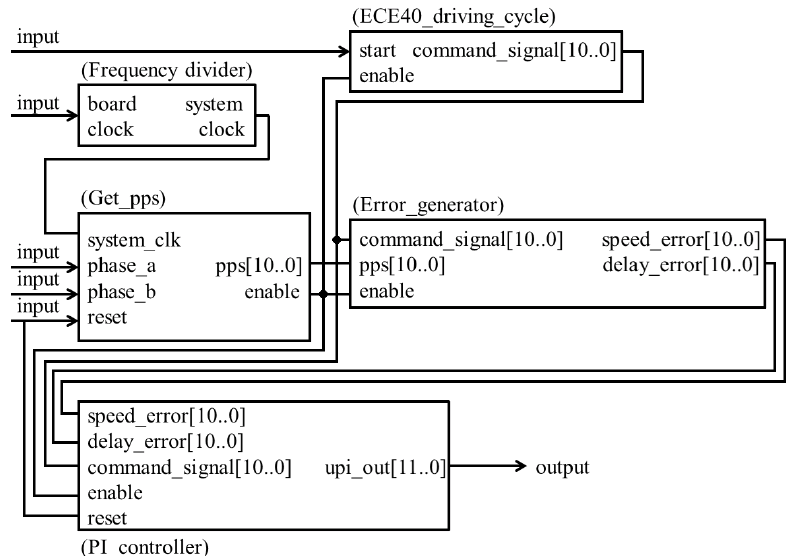
Figure 6. The block diagram of the PI speed